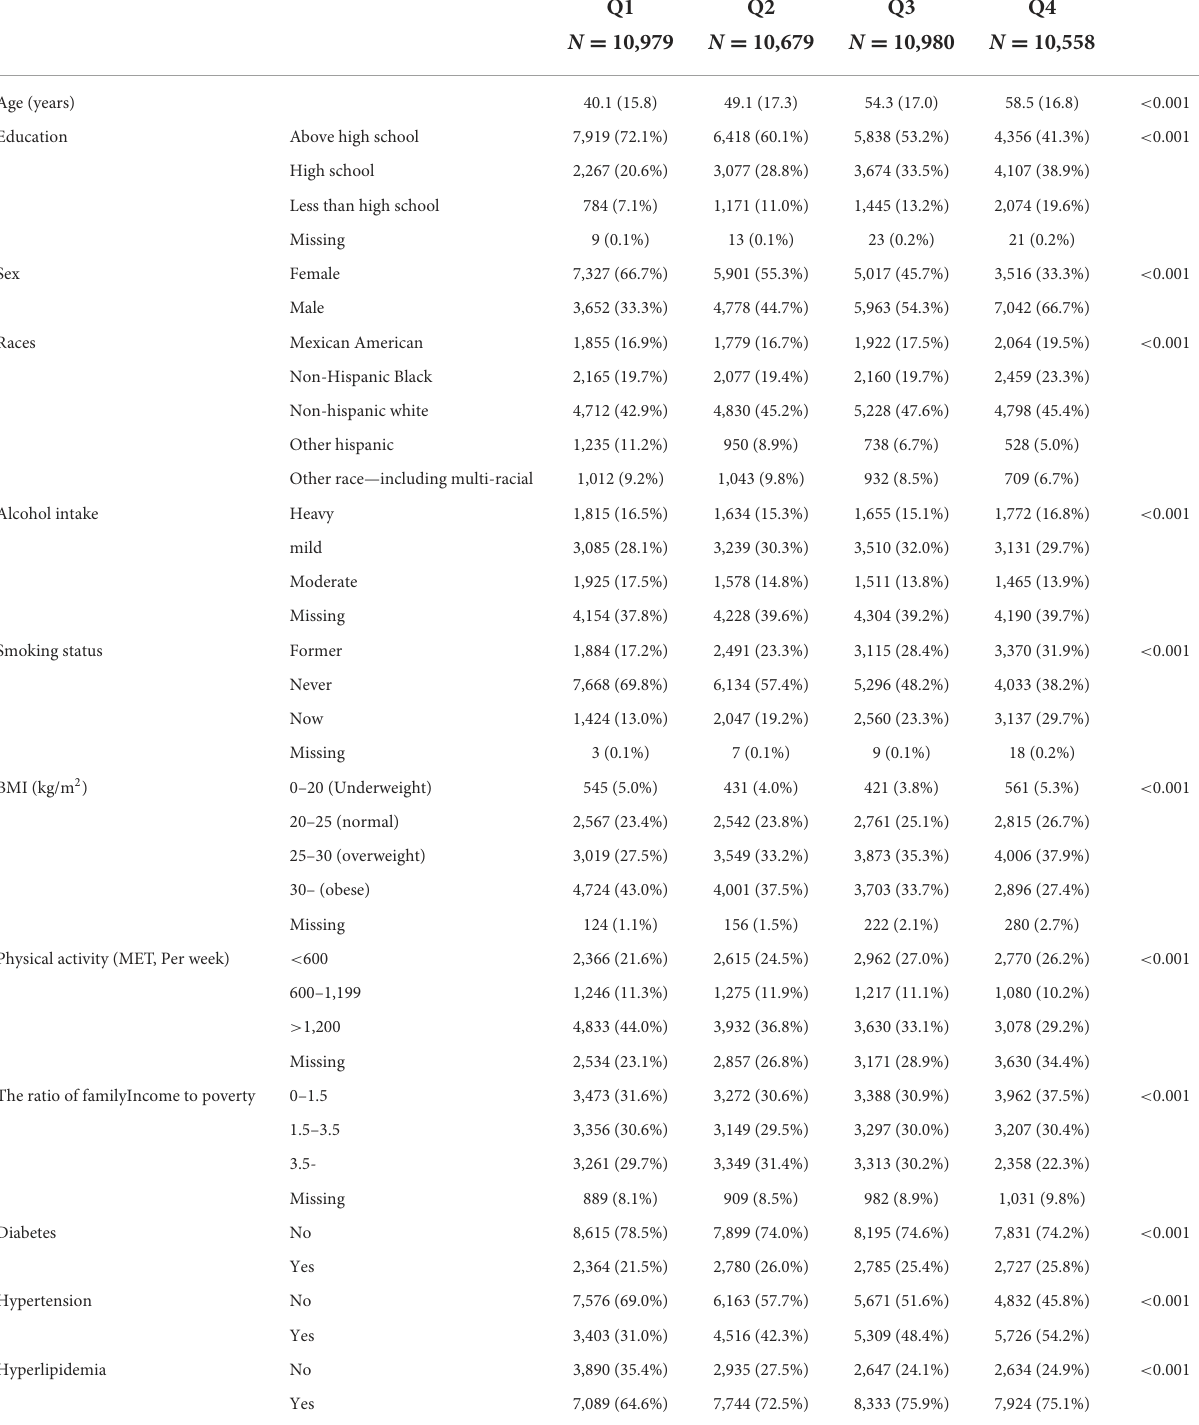
TABLE 1 Characteristics of NHANES samples